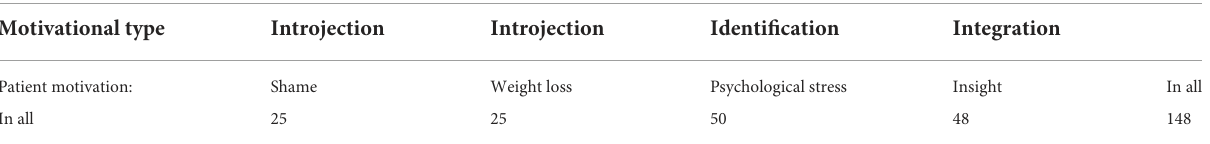
TABLE 3 Distribution of patients’ motivational types regarding therapy aims.